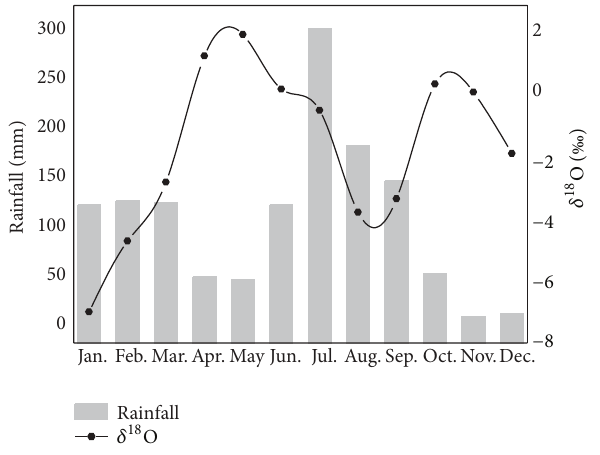
Figure 6: Average monthly variation of rainfall and 𝛿 18 O of Islamabad (1992–2006).